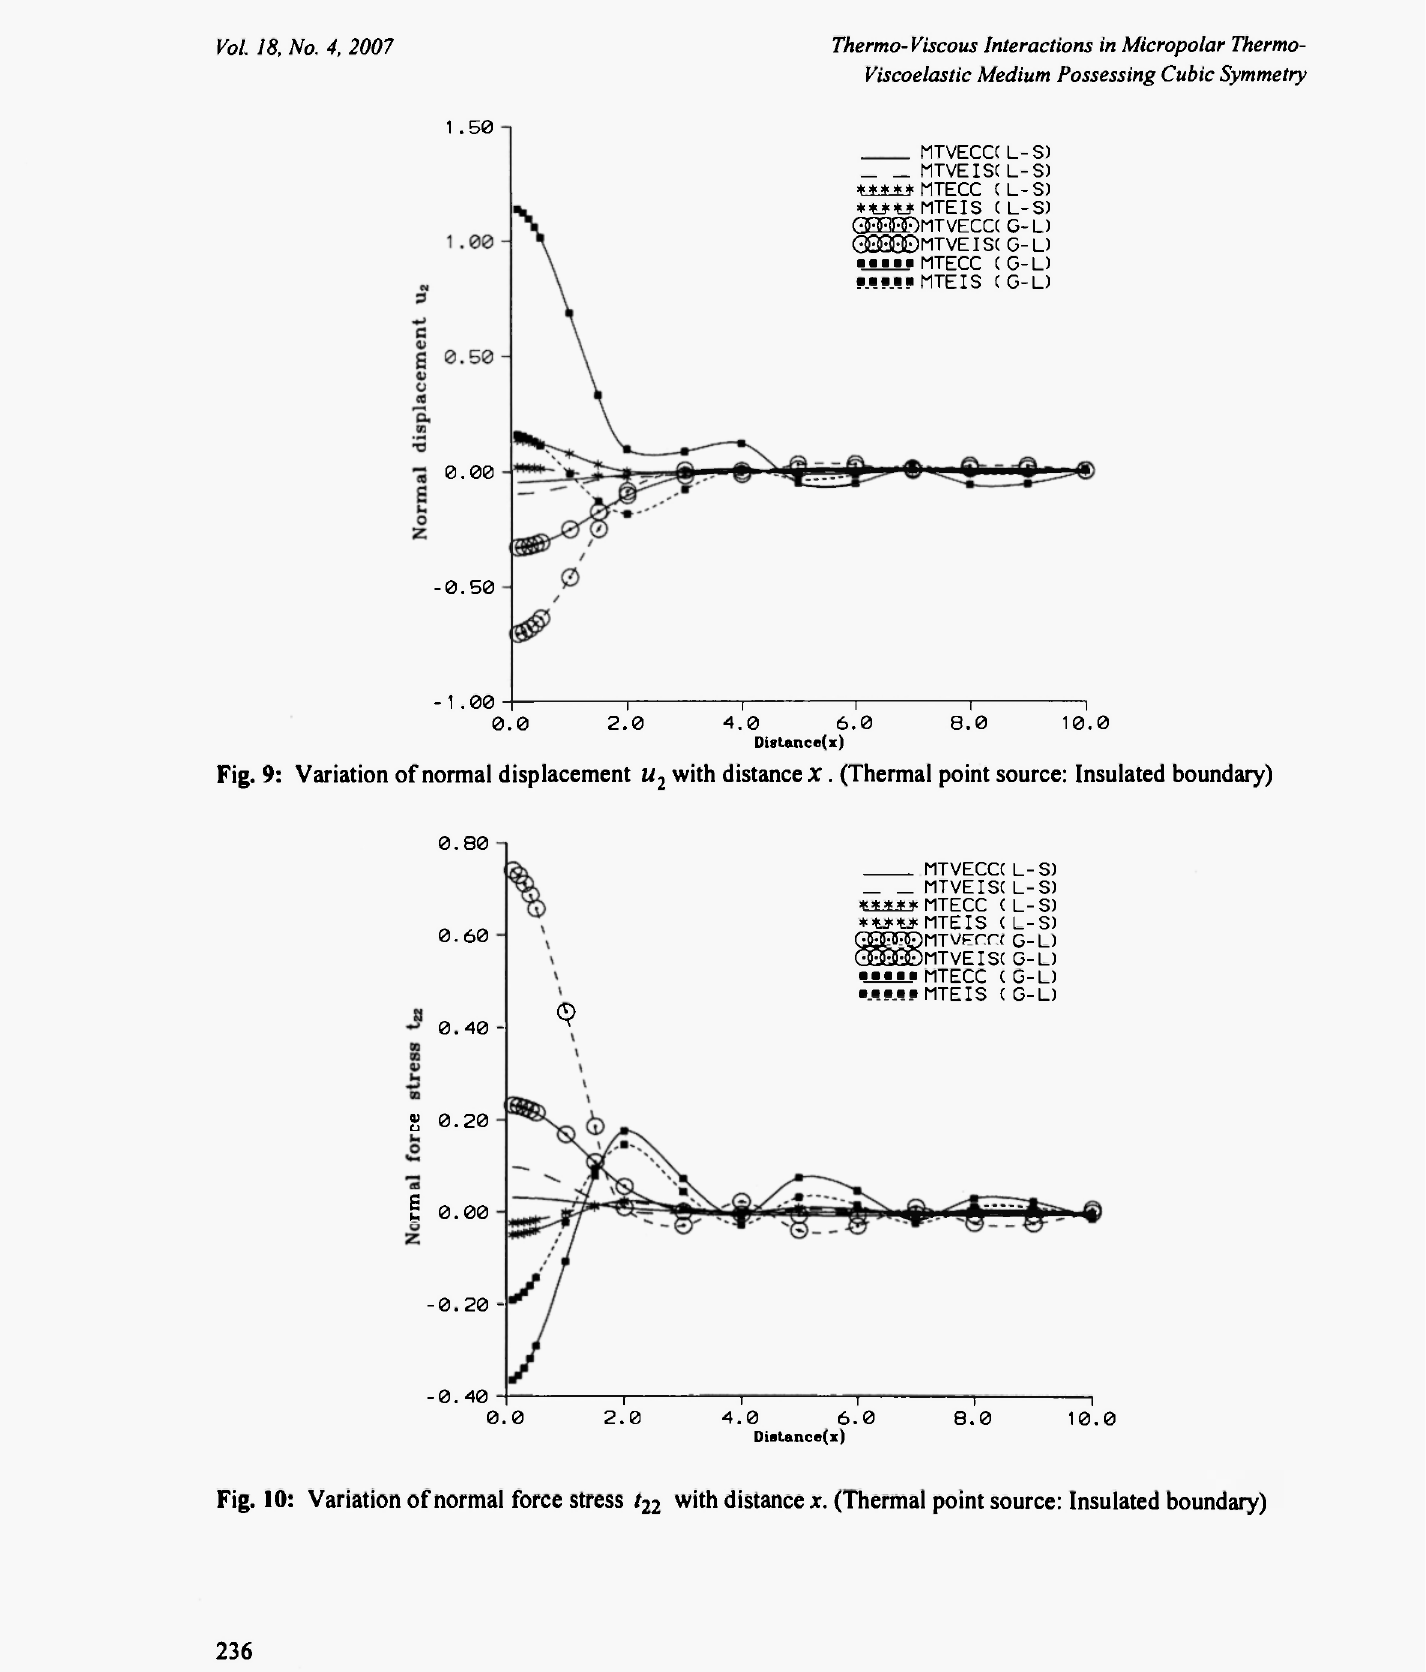
Fig. 10: Variation of normal force stress t 2 1 with distance x. (Thermal point source: Insulated boundary)